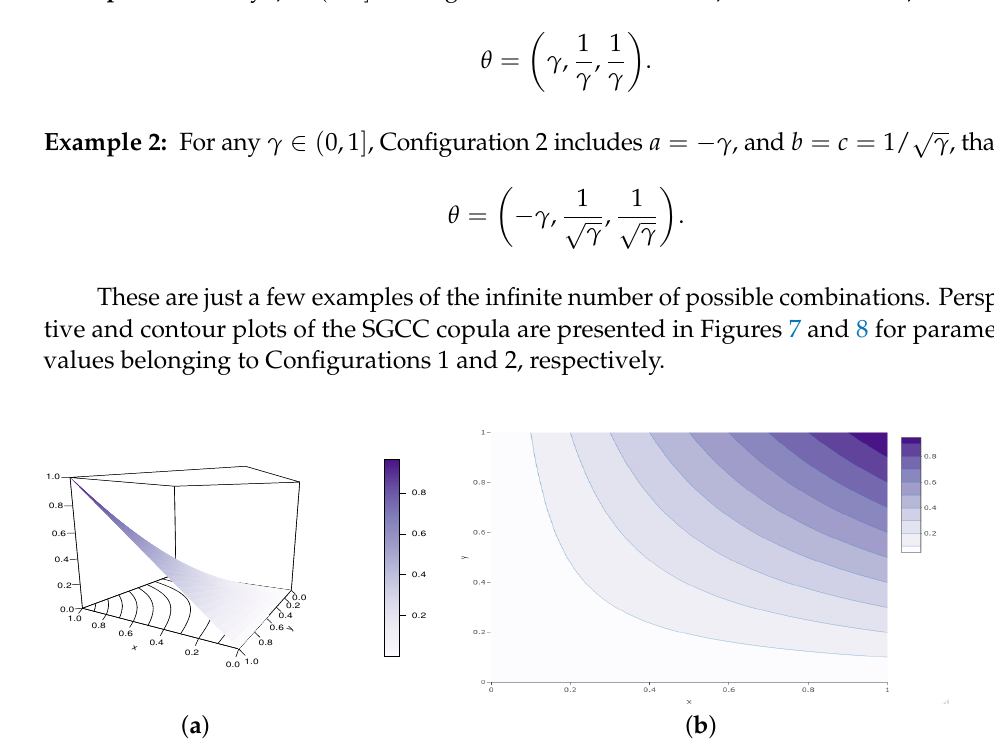
Figure 7. Illustrations of the ( a ) perspective plot and ( b ) contour plot of the SGCC copula for the following configuration: a = 1/4 and b = c = 2, belonging to Configuration